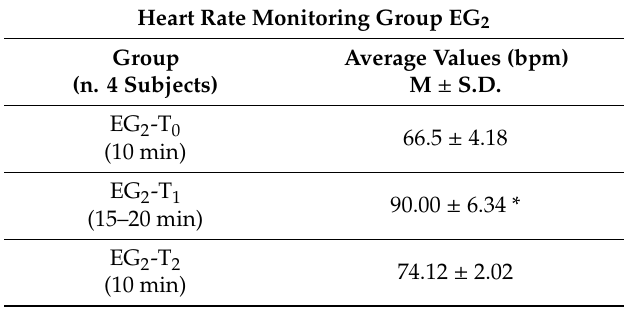
Table 5. Average values (Mean ± S.D.) of the heart rate—expressed in beats / minute (bpm)—of Amiata donkeys (experimental group EG 2 ), at the times T 0 , T 1, and T 2 of the AAI session.